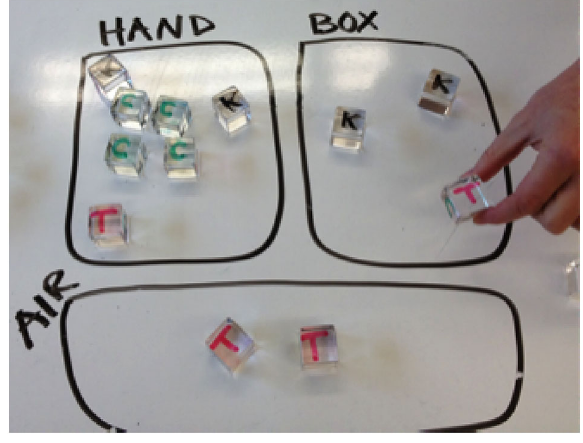
FIG. 2 (color online). Energy Cubes representation of a hand lifting a box